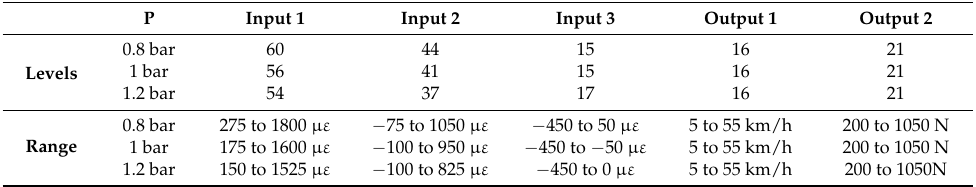
Table 1. Number of levels and range of each variable.